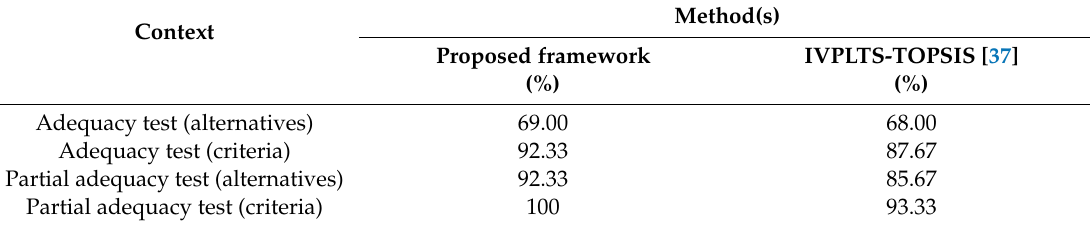
Table 8. Investigation of adequacy test: Proposed vs. others.